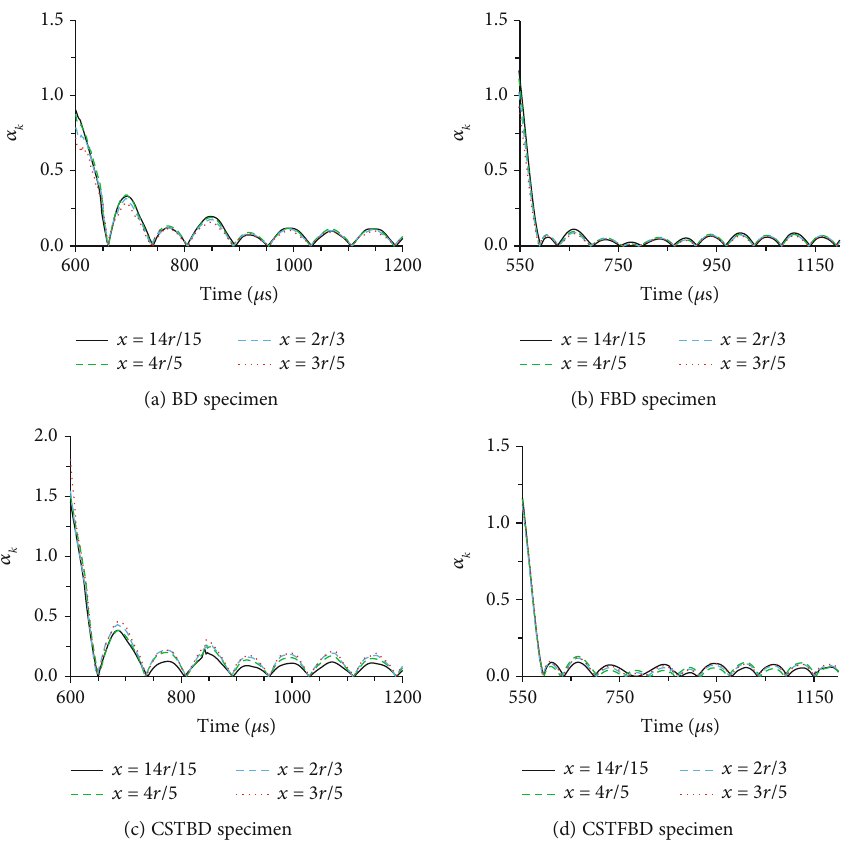
Figure 14: Stress balance factor curve on the loaded diameter ligament of four types of disc specimens.